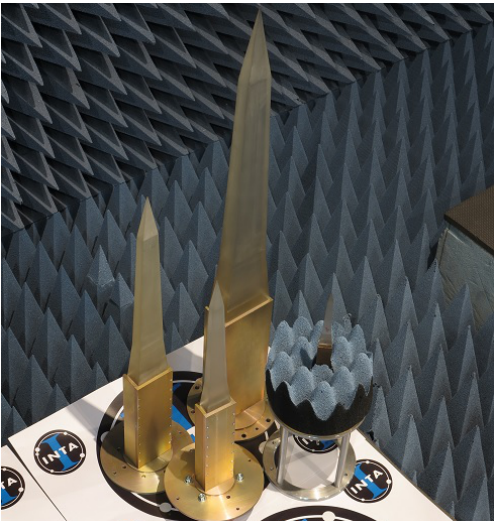
Figure 9. 2.6 GHz to 18 GHz polyrod antennas.